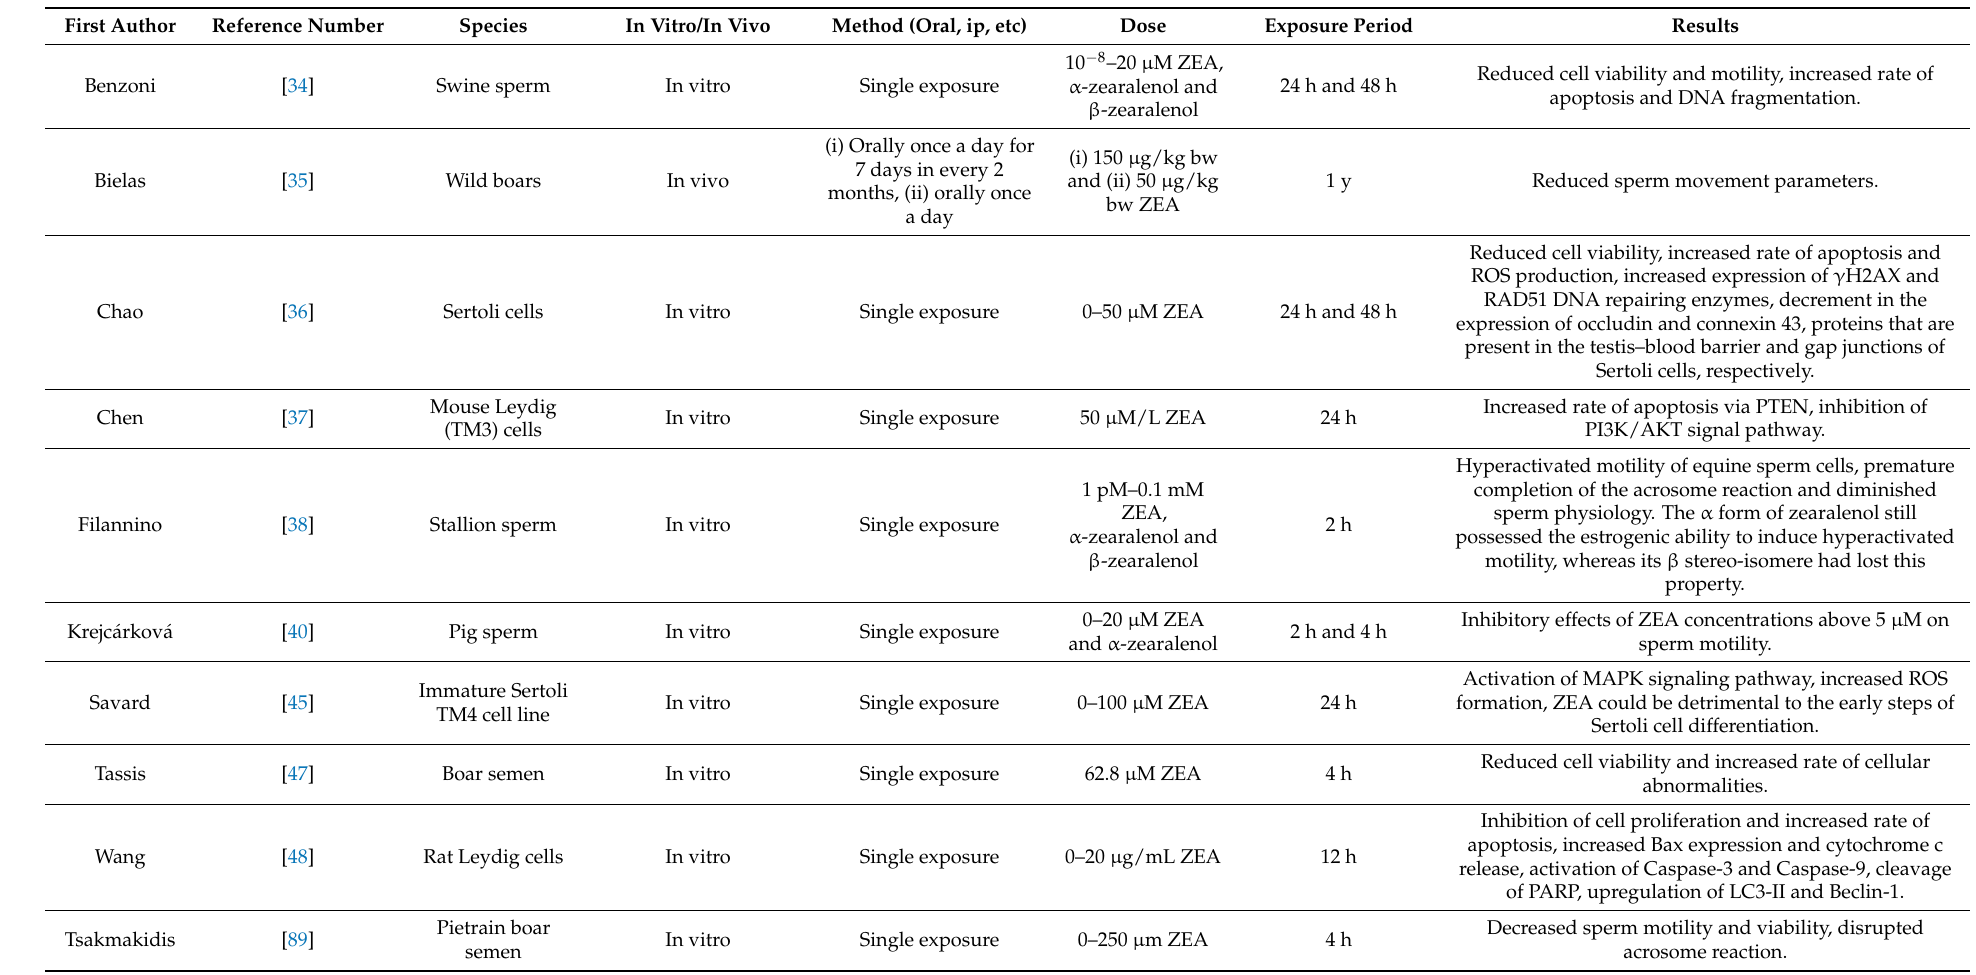
Table 2. Main data characteristic of reviewed studies which deal with non-estrogen-dependent